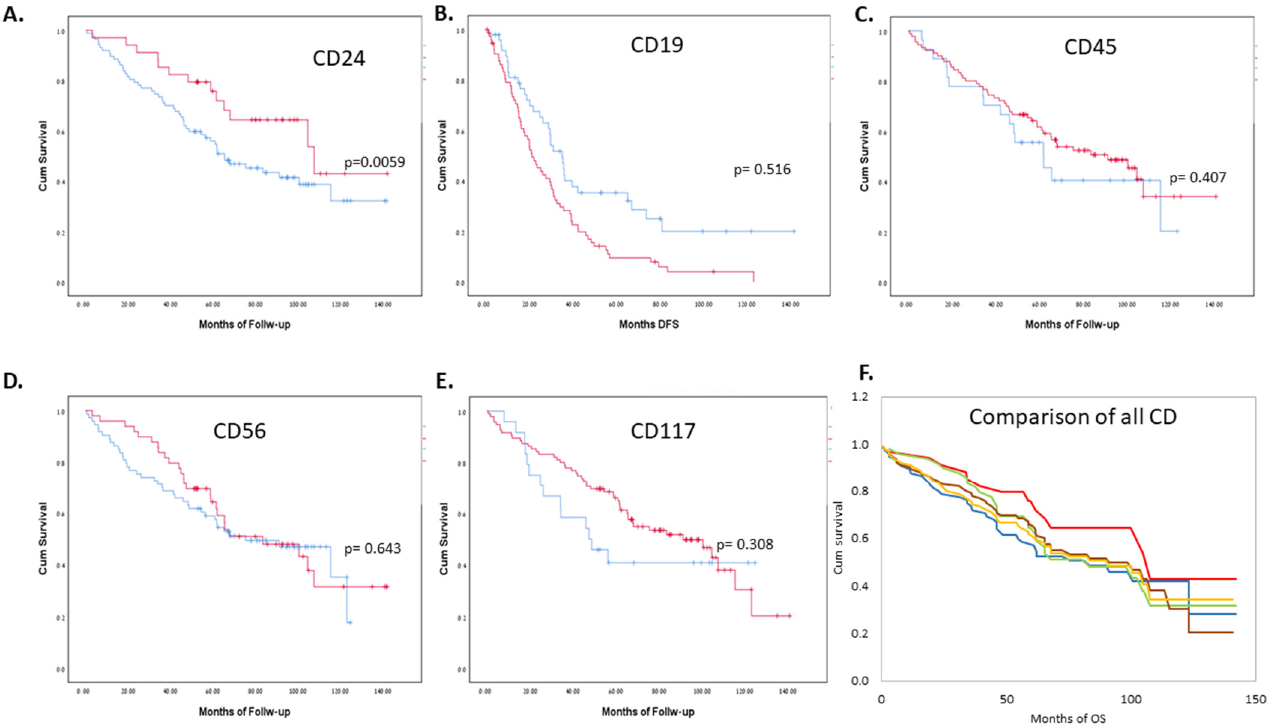
Figure 3. ( A – E ) Correlation of overall survival (OS) to the CD levels measured by MFC at diagnosis, with a cutoff expression level of 5% on PCs (red above 5%, blue below 5%). ( F ) A visual comparison of the different CDs, pooled ( F ). All lines represent the expression of CD above 5%. CD24-red, CD117-brown, CD19-blue, CD45-yellow, CD56-green.